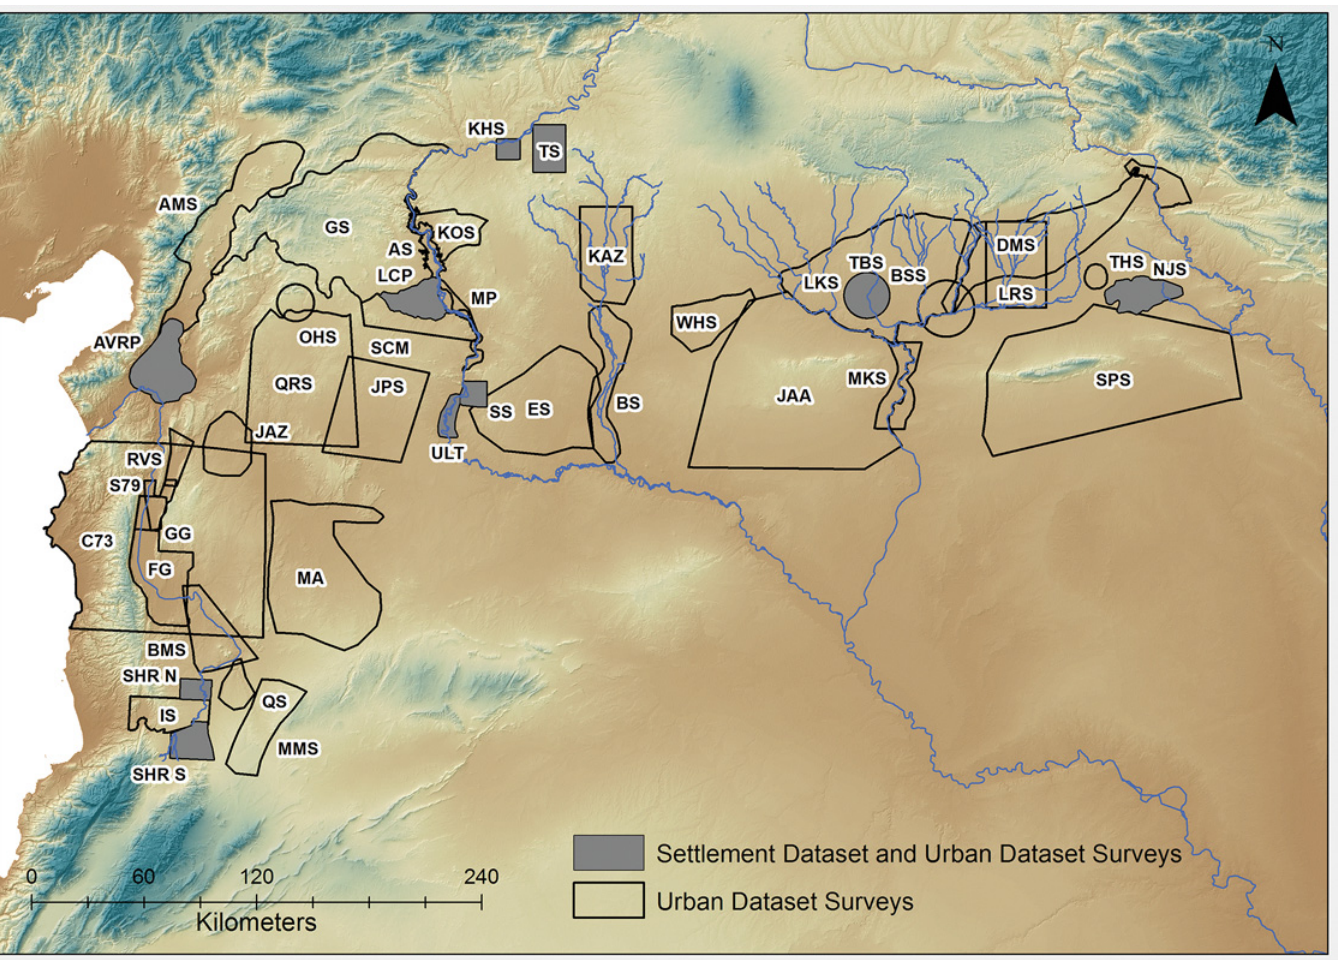
Fig 1. Surveys used in this paper. Shaded surveys provide sample site areas and densities, other surveys provide information for the urban dataset. Background SRTM DEM courtesy of the U.S. Geological